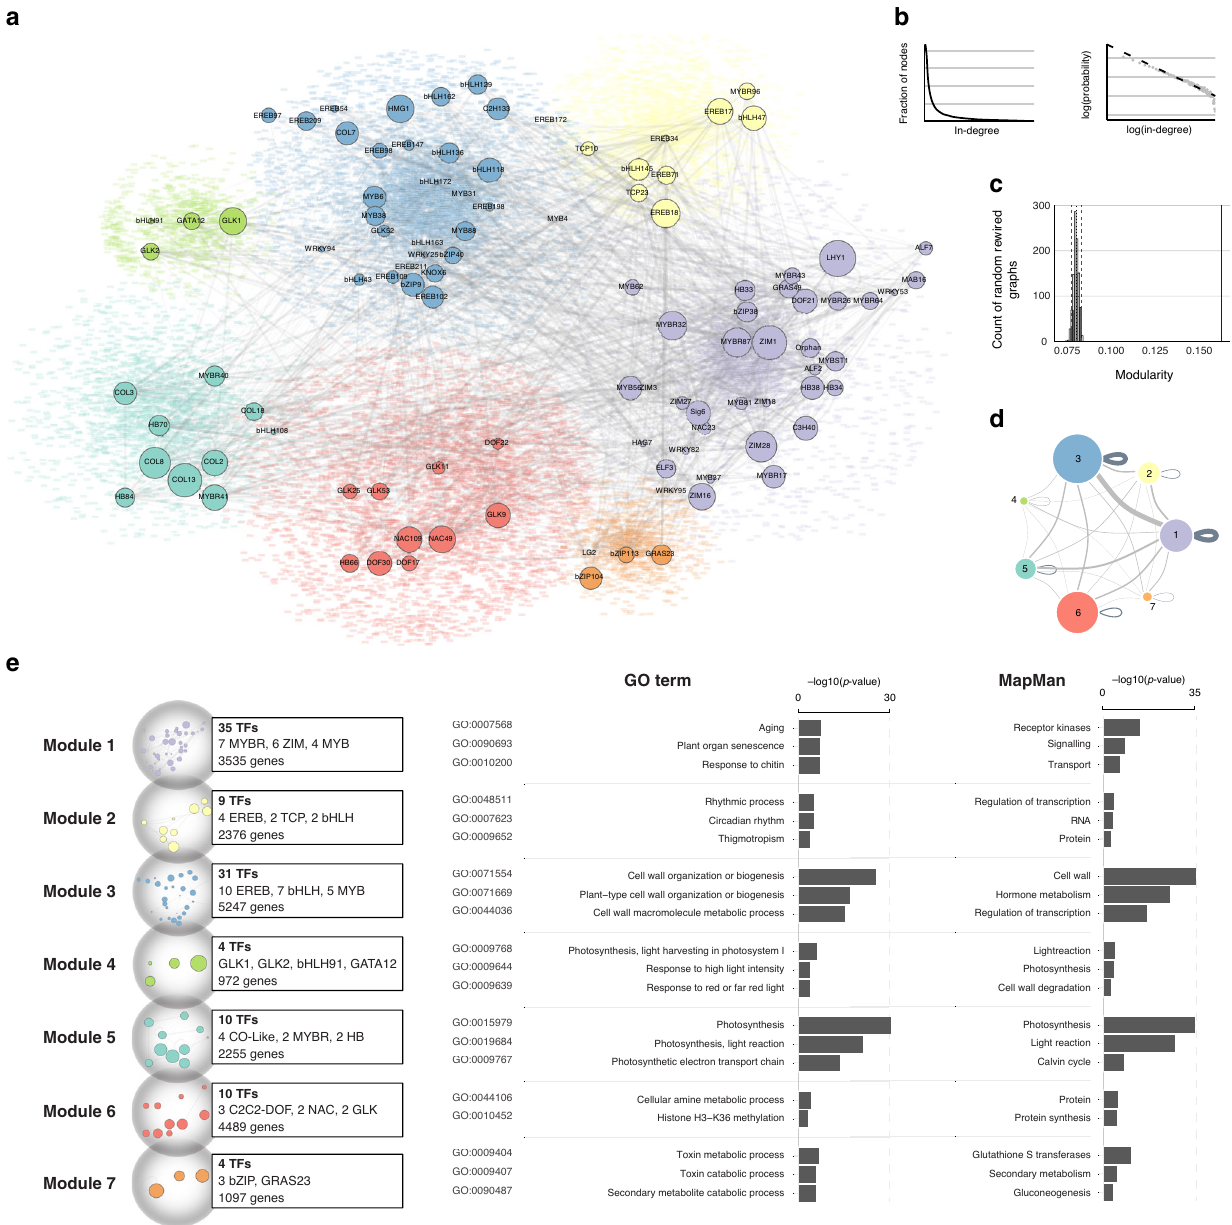
Fig. 4 The maize transcription regulatory network exhibits properties of real-world networks. a Graph diagram showing the maize transcription regulatory network. The seven modules are labeled in different colors. TF nodes are shown as circles with size representing their expression level, and their target genes are shown as colored dots in the background. TF-to-TF edges are shown as gray lines between nodes. b Distribution of node in-degree values fi ts the power-law (dashed line). c Modularity of the network (blue line) is higher than the random control (histogram of maximum modularity values of 1000 rewired graphs). d Graph diagram showing TF-to-gene connections within and between modules. Each module is represented as a circle with size proportional to the number of nodes within. e GO-term and MapMan category enrichment analysis of genes in each module. Source data underlying Fig. 4e are provided as a Source Data fi ( P value < 0.001, Fig. 6c). Overall, our fi nding suggests a strong